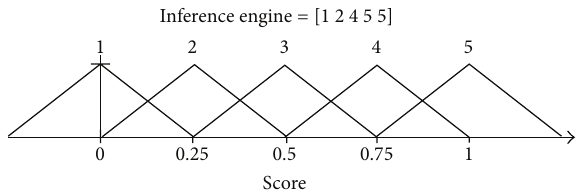
Figure 7: Inference engine and consequent membership functions sensor classification accuracy.